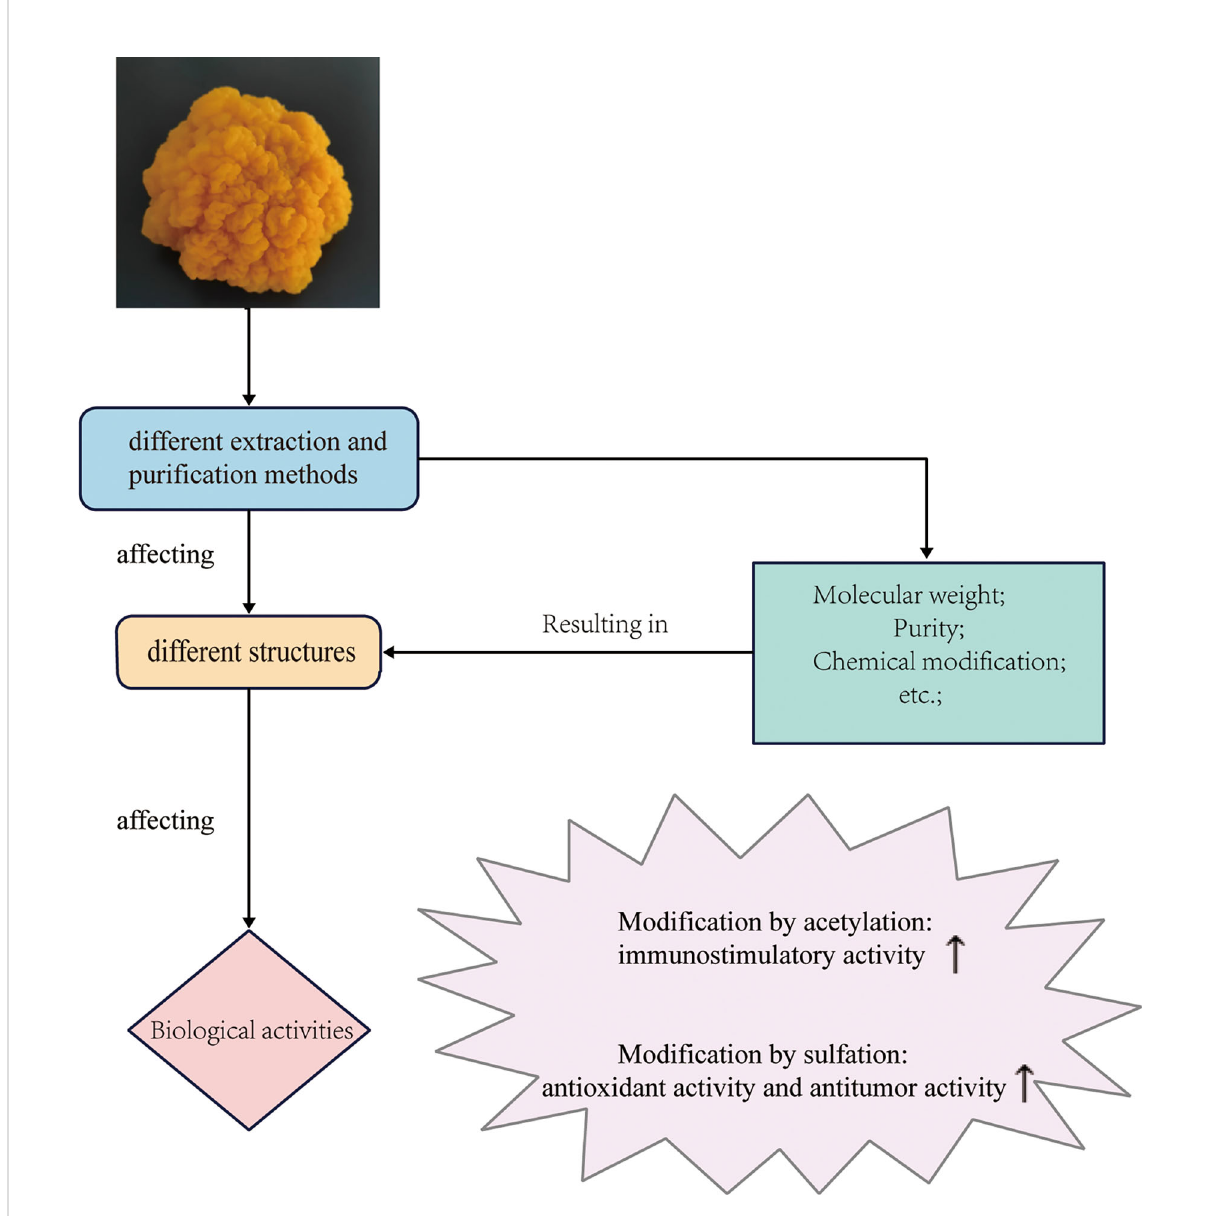
FIGURE 3 Structure-activity relationship of T. aurantialba